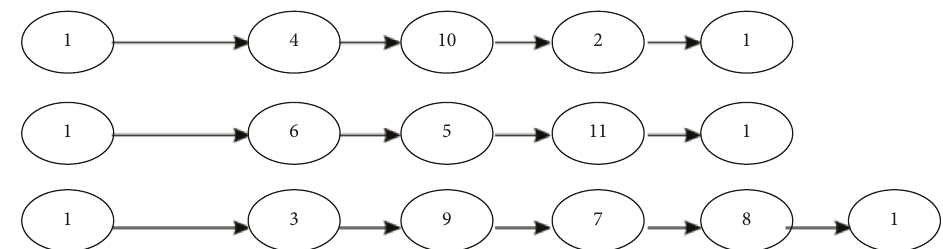
Figure 4: Details of the routes formed in the third period.